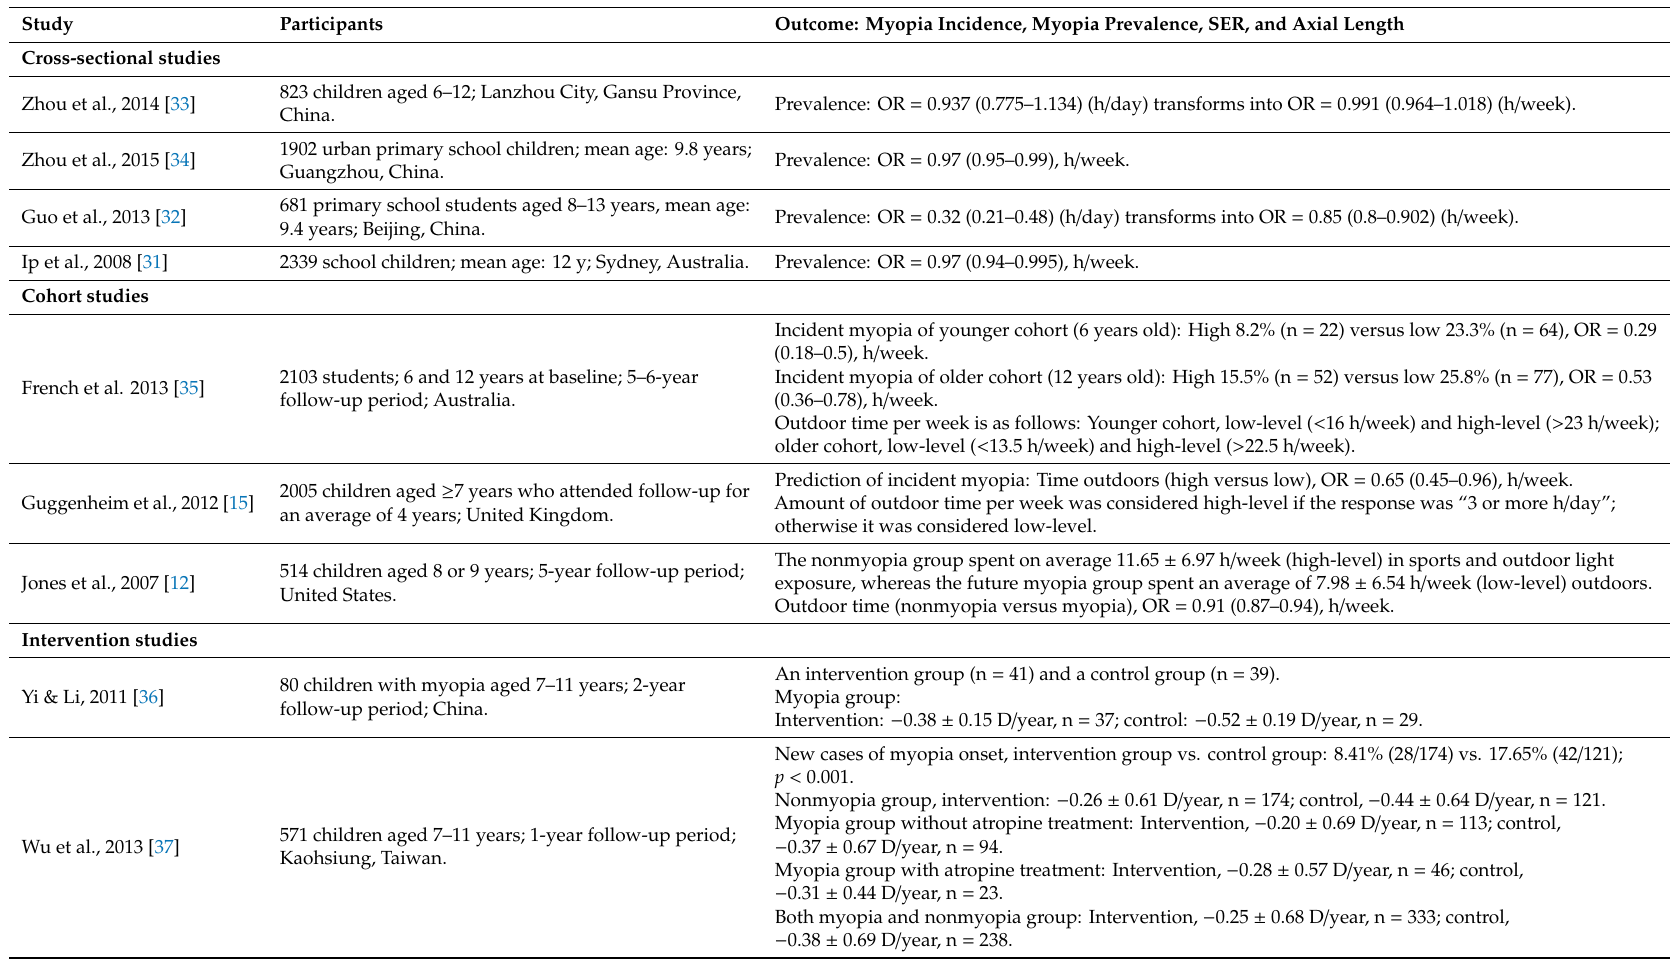
Table 1. Characteristics of the studies included in the meta-analysis of outdoor light exposure and